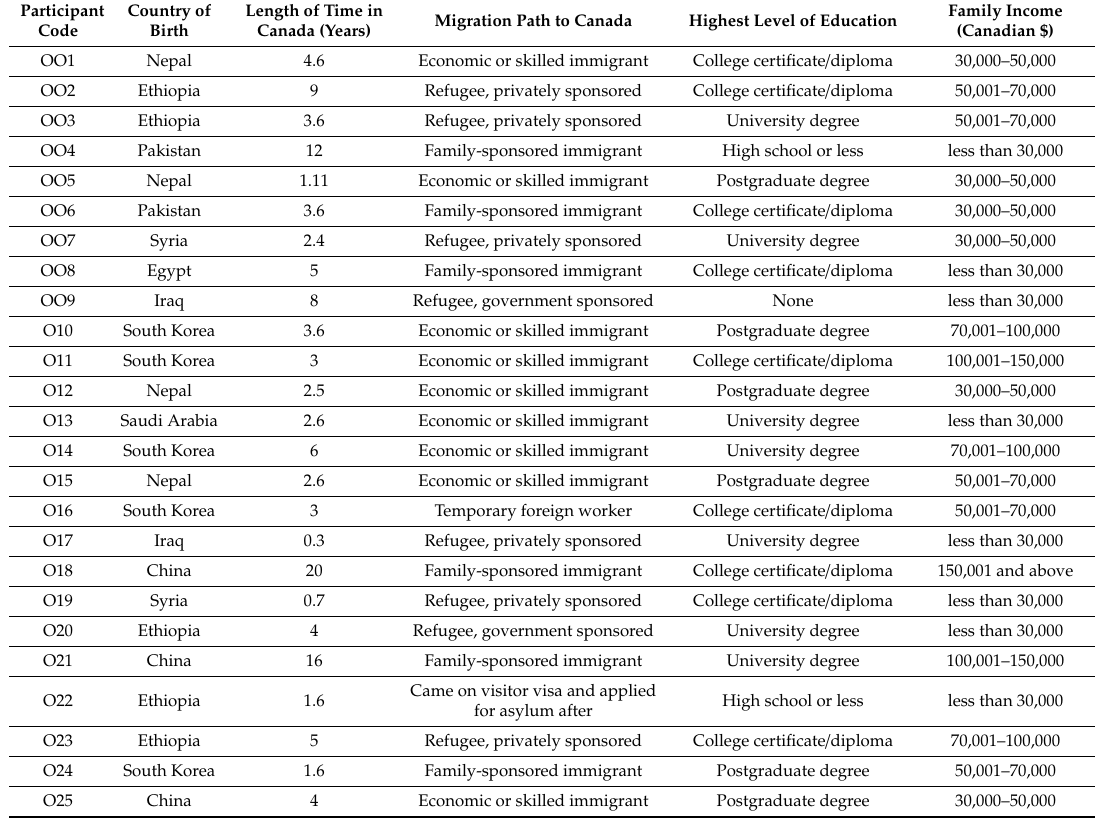
Table 1. Demographic Description of